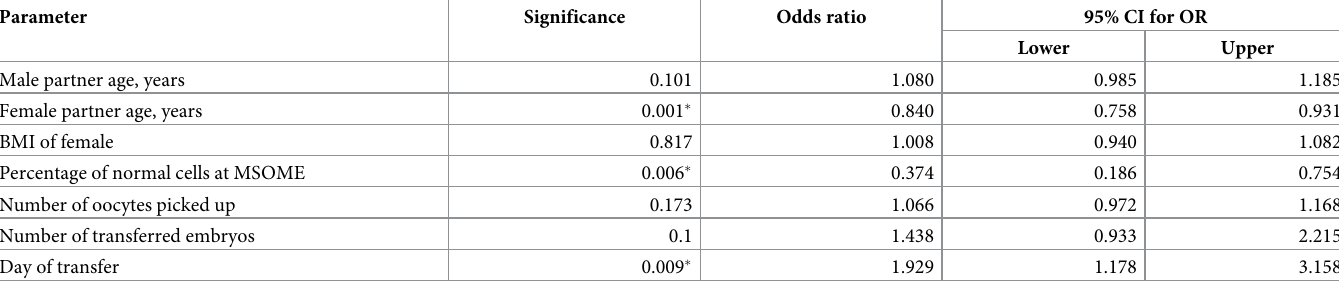
Table 2. Logistic regression on pregnancy